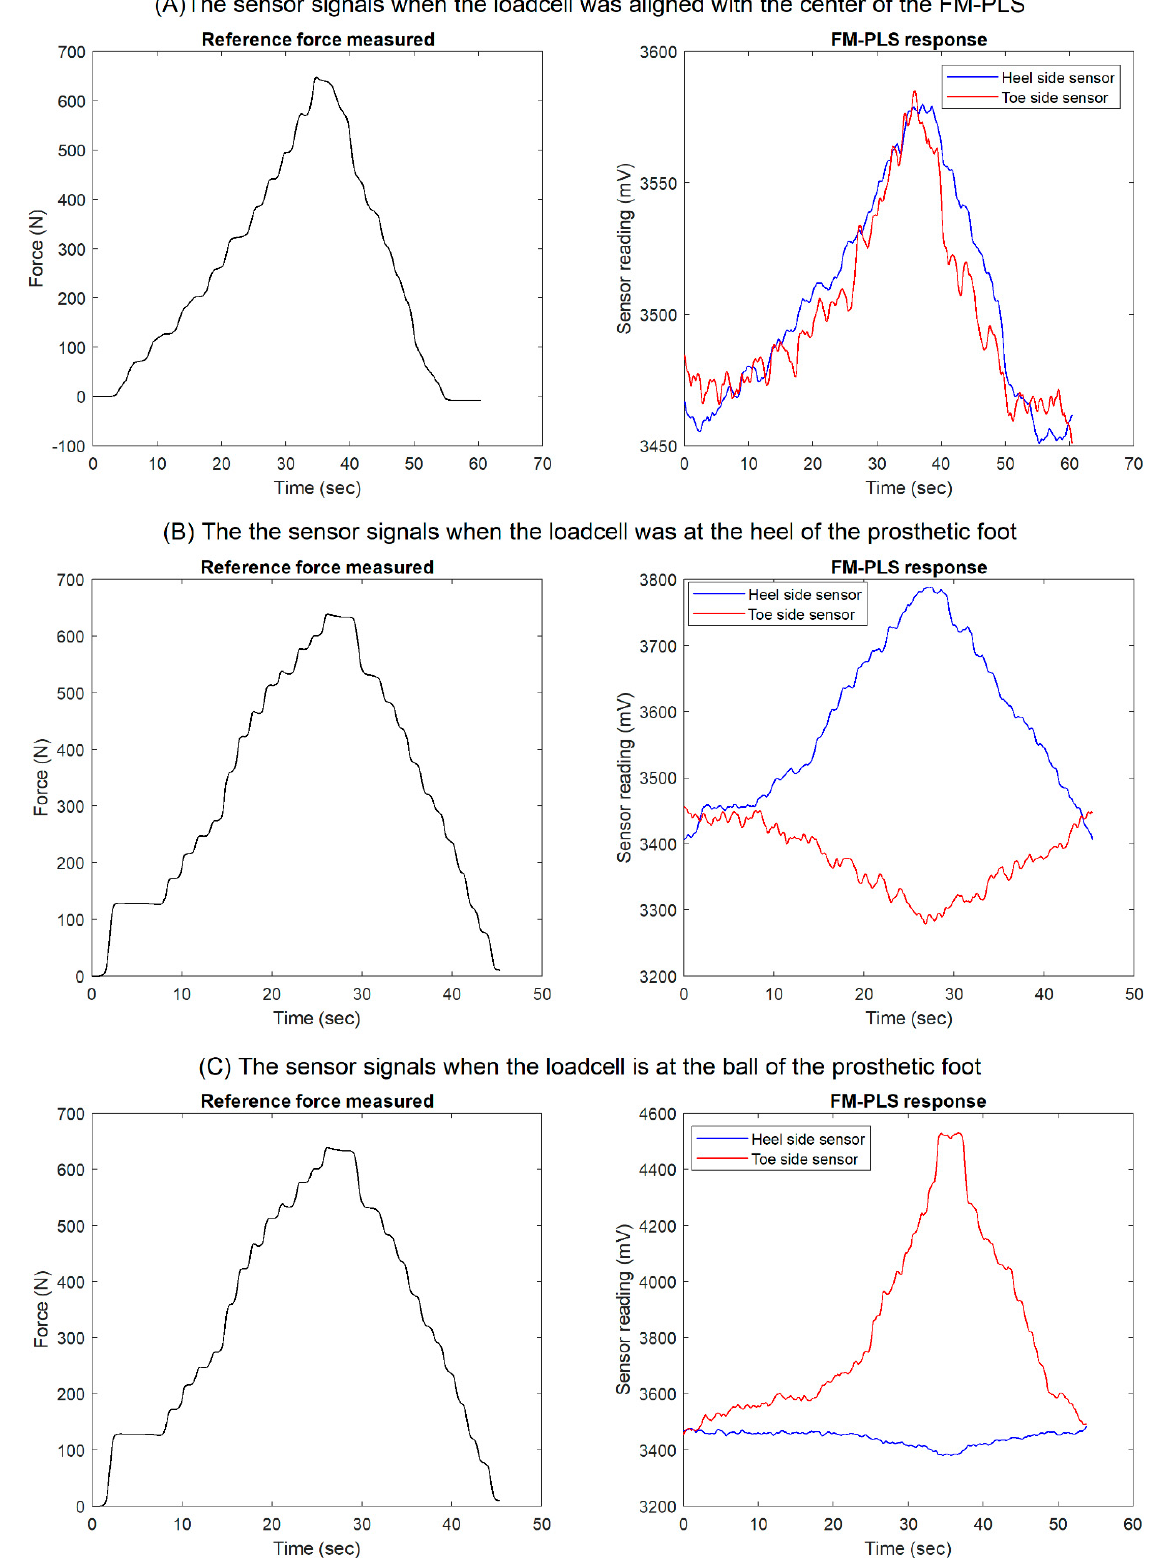
Figure 11. Benchtop testing results: reference measure, heel side and toe side magnetic flux sensor responses while the off-the-shelf loadcell was ( A ) aligned with center of the FM-PLS (shown in Figure 9, left column), ( B ) at the heel of the prosthetic foot (shown in Figure 9, middle column), and ( C ) at the ball of the prosthetic foot (shown in Figure 9, right column).